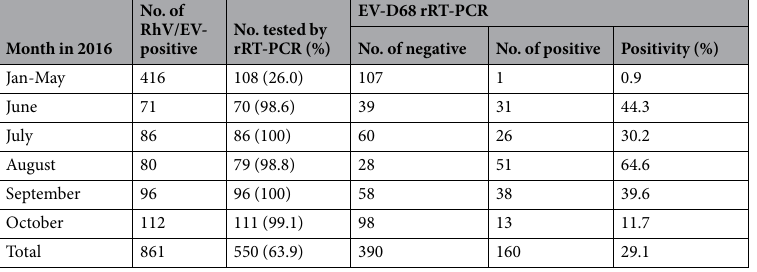
Table 2. Number of nasopharyngeal specimens examined by the FilmArray Respiratory Panel and EV-D68 rRT-PCR from January to October 2016.